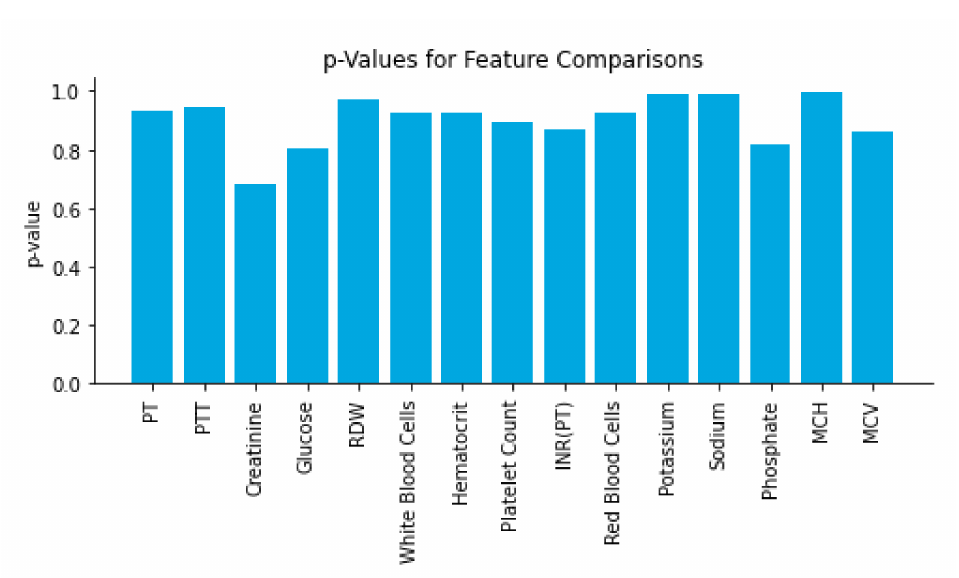
Figure 2. Time window vectors from the test set were fed into the model and compared with their generated counterparts. The real and simulated data was then compared on each feature using a t -test to gauge the closeness of the distributions; p -values for the test are reported in the